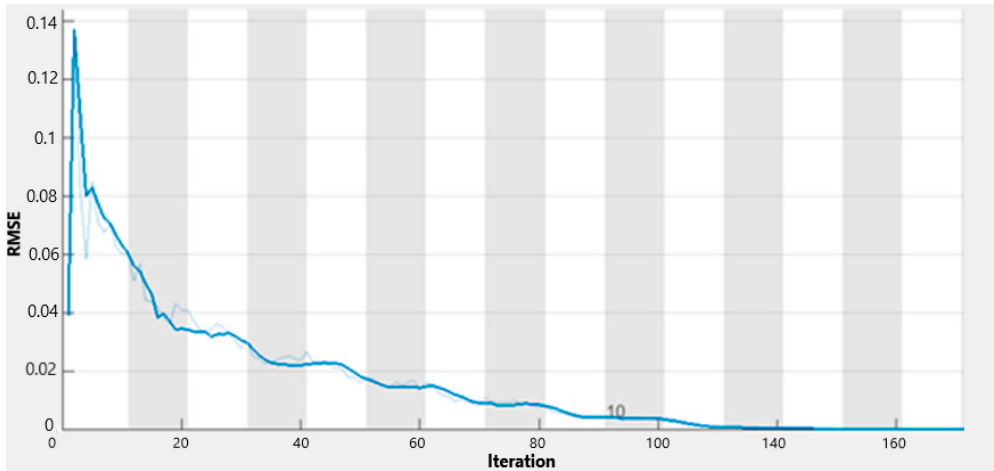
Figure 8. Loss performance of the proposed LSTM network during the training phase.